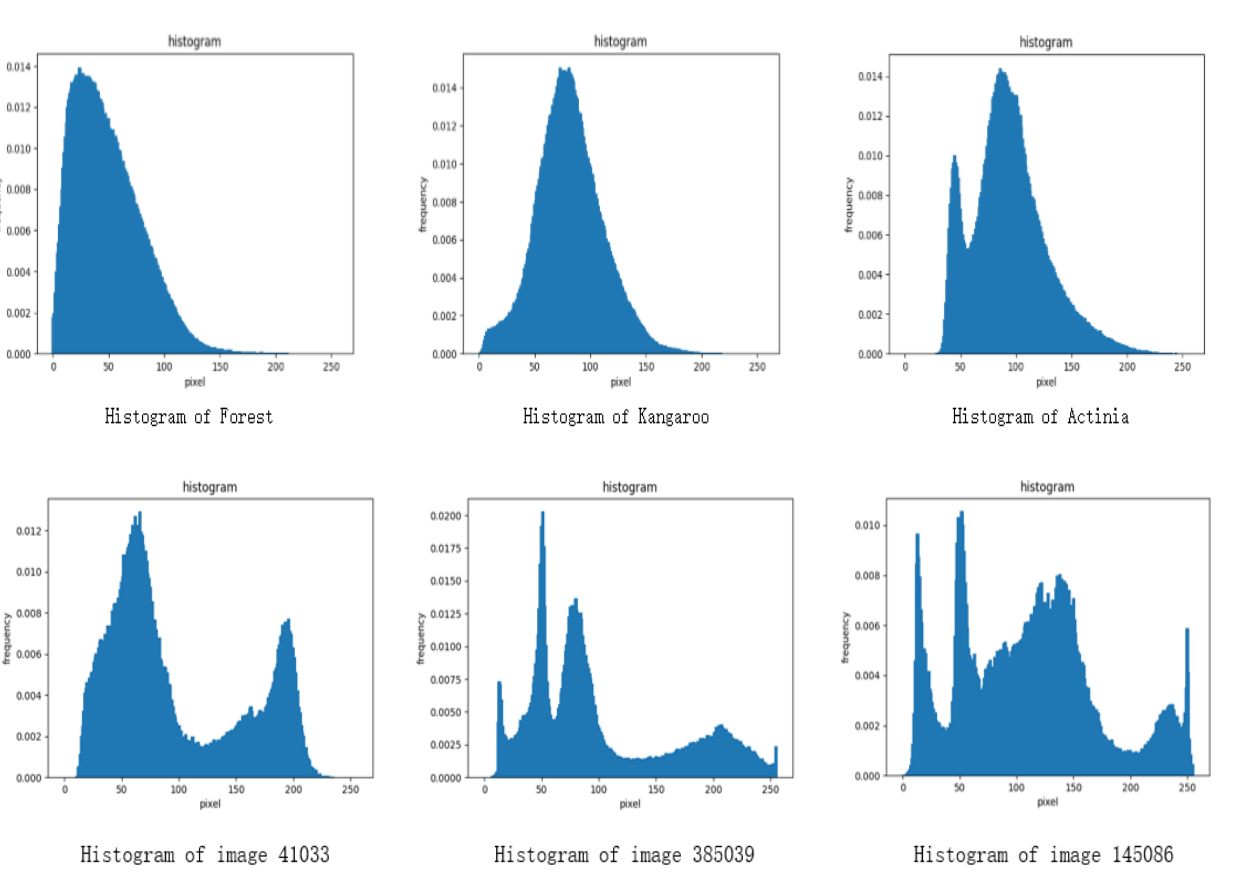
Figure 2. Histogram distribution. Table 1. Results comparison of five algorithms for segmentation of images 1–3 on different criteria when D =